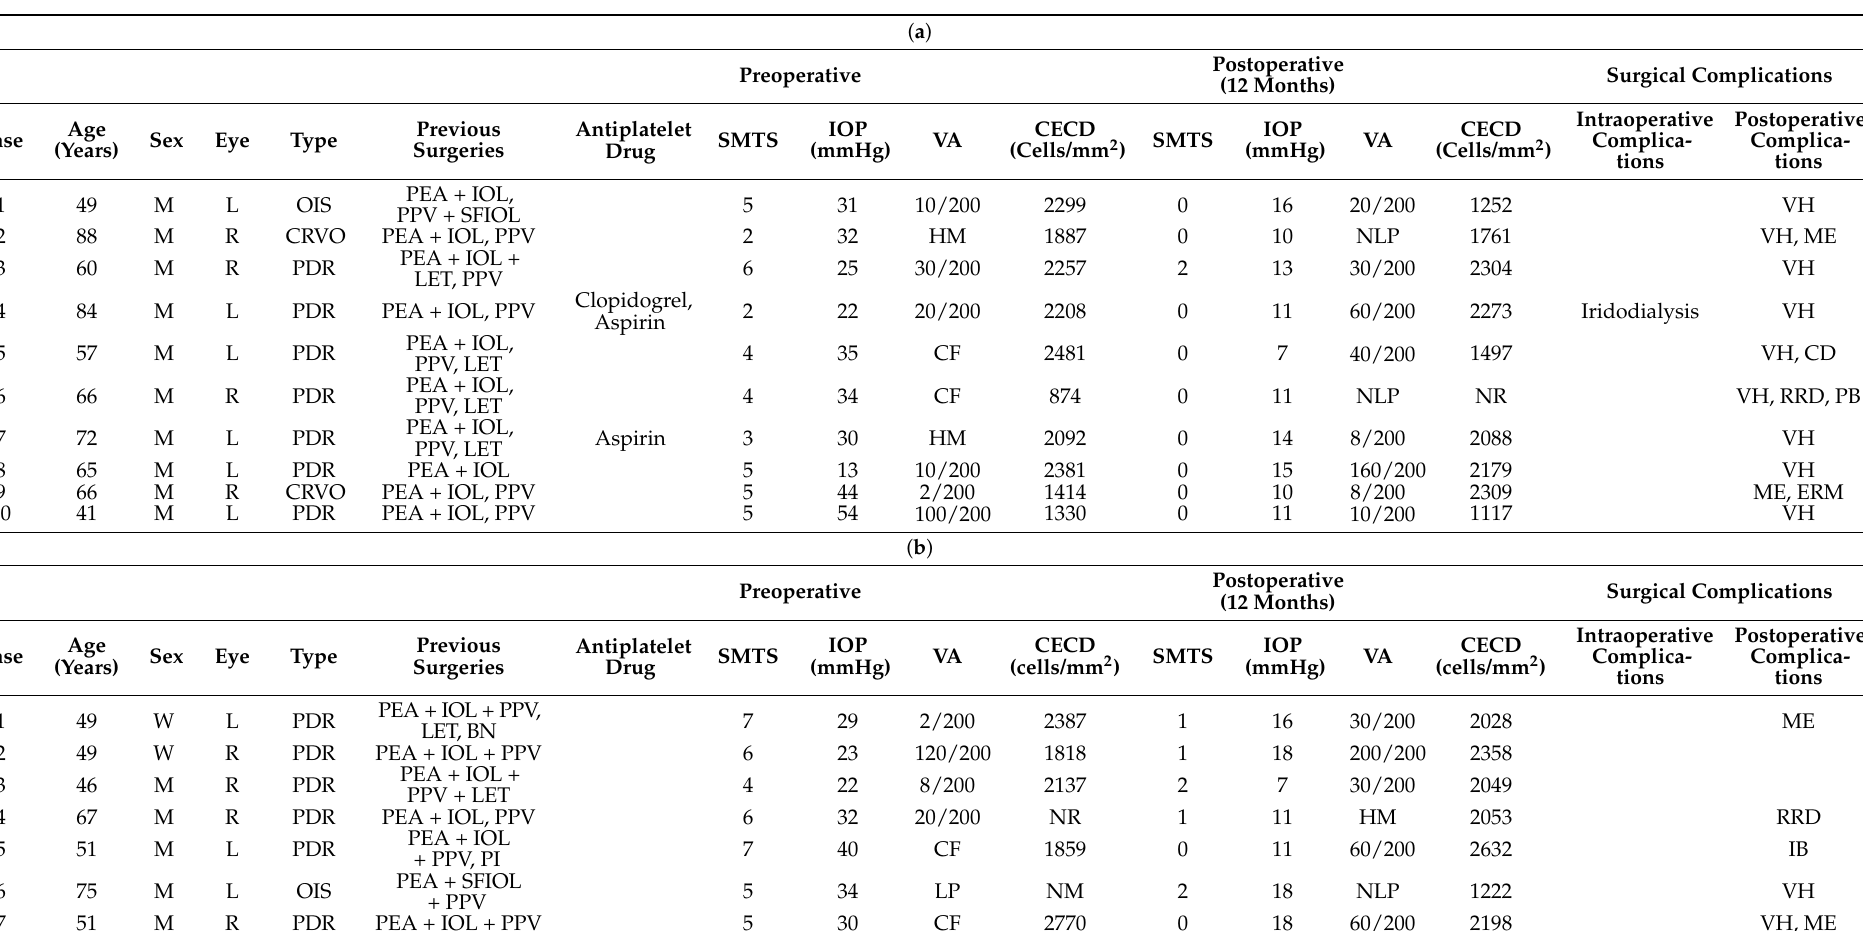
Table 1. ( a ) Summary of the double group. ( b ) Summary of the single